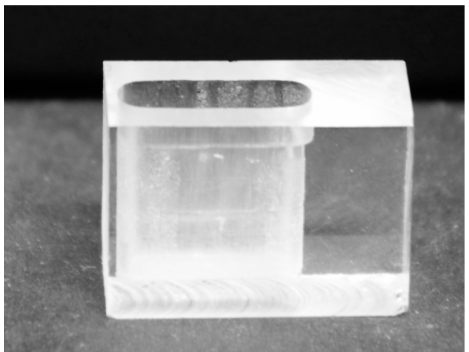
Figure 5. Poly(methyl methacrylate) (PMMA) cuvette, with 8 mm width, 7 mm height and 2.5 mm thickness used in the acoustic streaming experimental